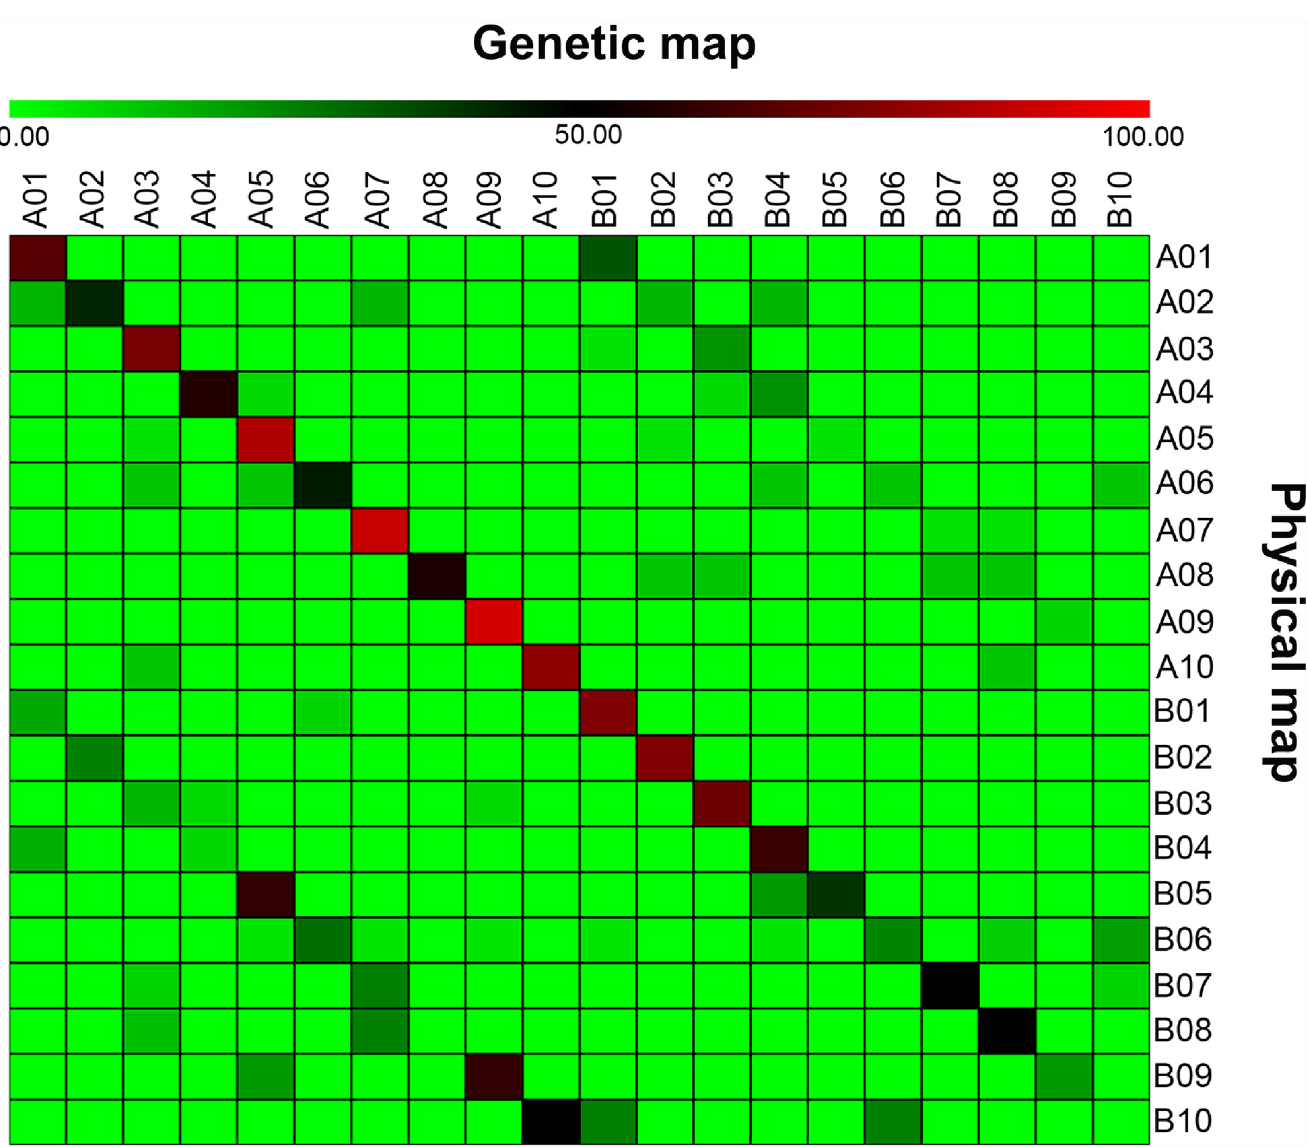
Fig 1. Comparison of markers mapped on different linkage groups (A01 to A10 and B01 to B10) of the genetic map of the S-population with the physical maps of two diploid peanut ancestors. The physical map of chromosomal pseudomolecules A01 to A10 of physical map of A sub-genome are from Arachis duranensis while that the B sub-genome B01 to B10, from A . ipaensis . Gradient color from light green to red denotes similarity percentage between the markers location in genetic map with that of physical map. The light green denotes 0% similarity, i.e. no common marker between the linkage group and the pseudomolecule, while red denotes 100% similarity, i.e. all the markers on one linkage group of genetic map were also present on the same pseudomolecule of physical